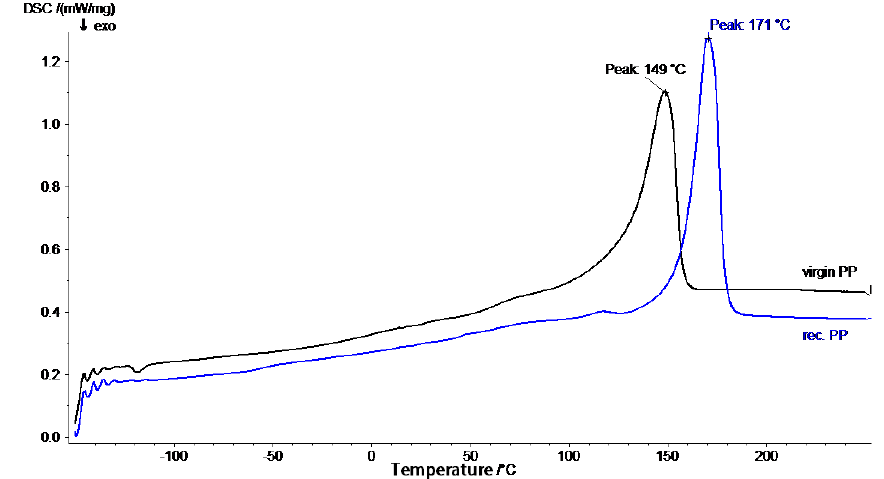
Figure 2. DSC plot for virgin polypropylene (PP) and recycled PP.